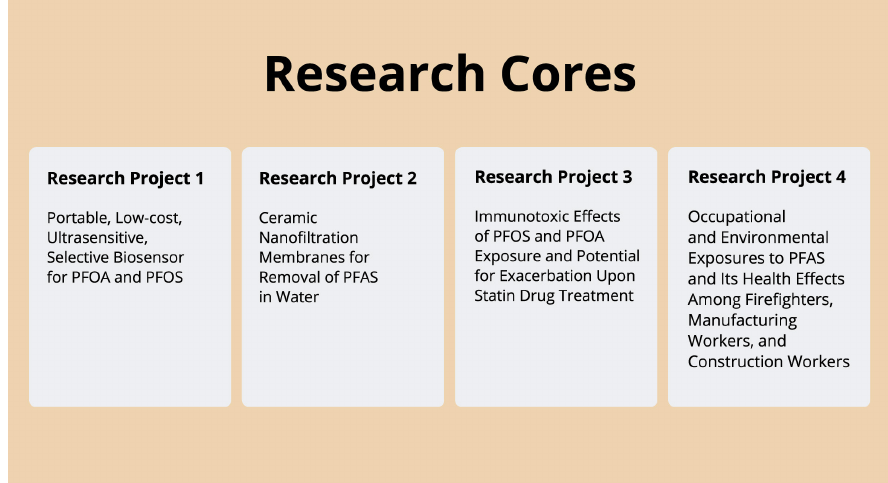
Figure 1 : Research Projects under the grant proposal. The Research Core, comprised of 4 research projects is one of 5 Cores proposed for the